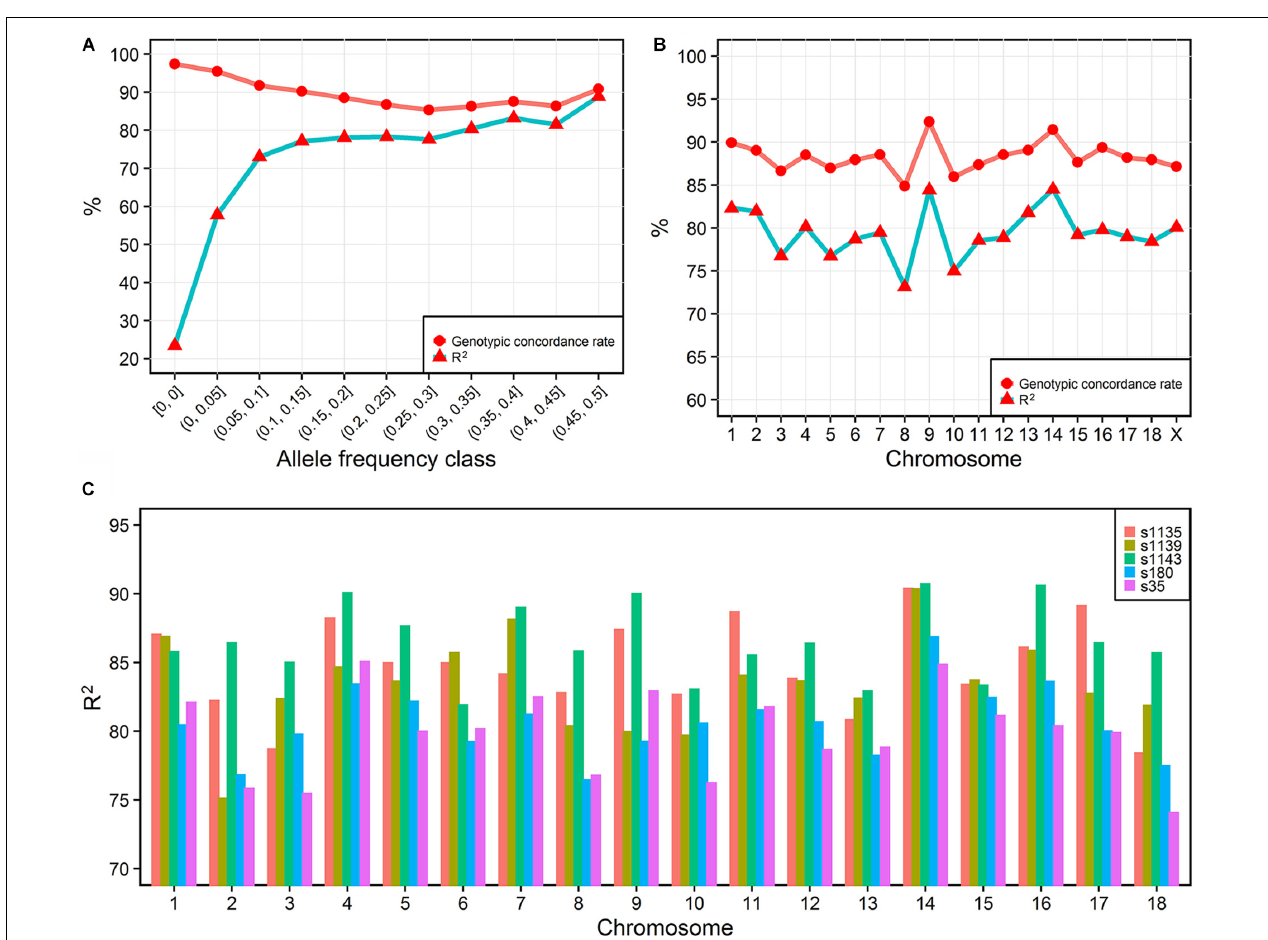
FIGURE 2 | Imputation accuracy. The imputation accuracy from IMPUTE2 internal cross-validation across MAFs (A) and chromosomes (B) . R 2 is the squared correlation. The squared correlation between five sequenced and imputed individuals (C) .